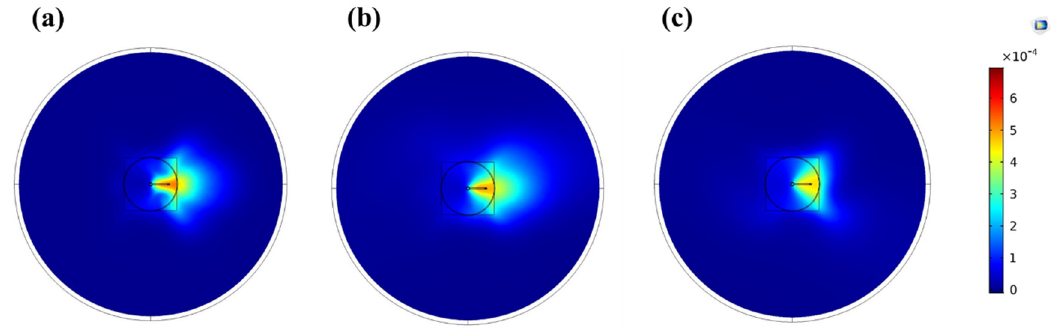
Figure 8. Top view (XY-plane) of the monomer mass fraction distribution for ( a ) 3 mm, ( b ) 5 mm, and ( c ) 7 mm gap sizes. The monomer-containing gas flow rate was fixed at 250 sccm.